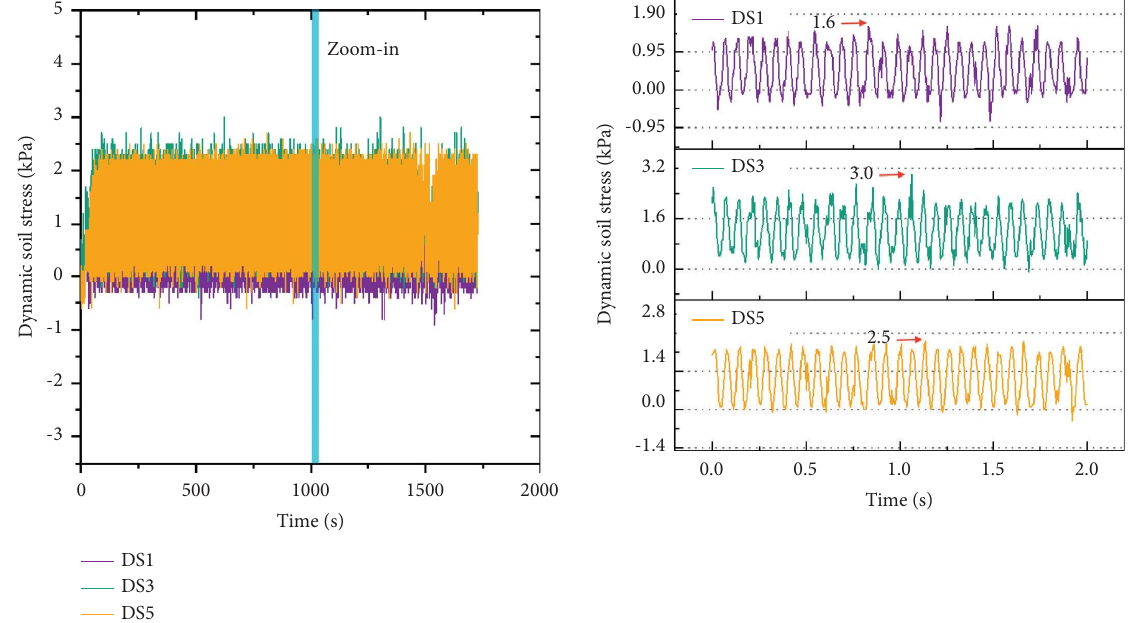
Figure 7: Te time-history response curve of dynamic soil pressure.